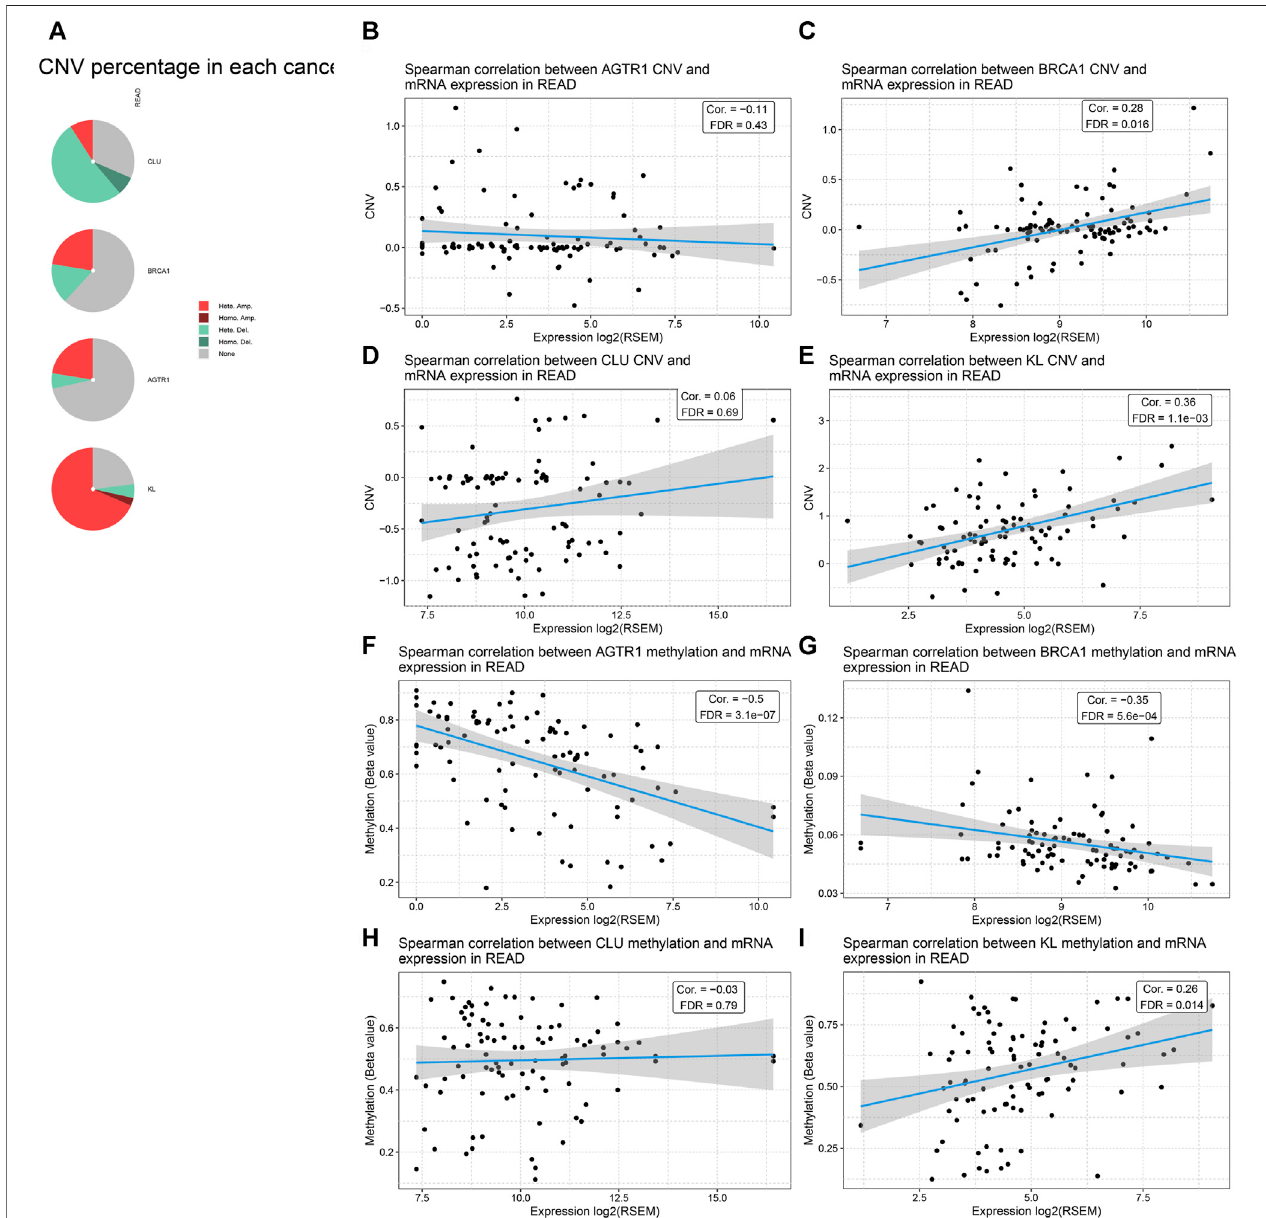
FIGURE7| AnalysisofCNAs and methylationlevels ofBRCA1, CLU,AGTR1,andKLacrossrectalcancerthroughcBioPortal. (A) Landscapeofmutationtypes in BRCA1, CLU, AGTR1, and KL across rectal cancer. (B – E) Spearman correlation of BRCA1, CLU, AGTR1, and KL expression with their corresponding CNA values in rectal cancer. (F – I) Spearman correlation of BRCA1, CLU, AGTR1, and KL expression with their corresponding methylation levels in rectal